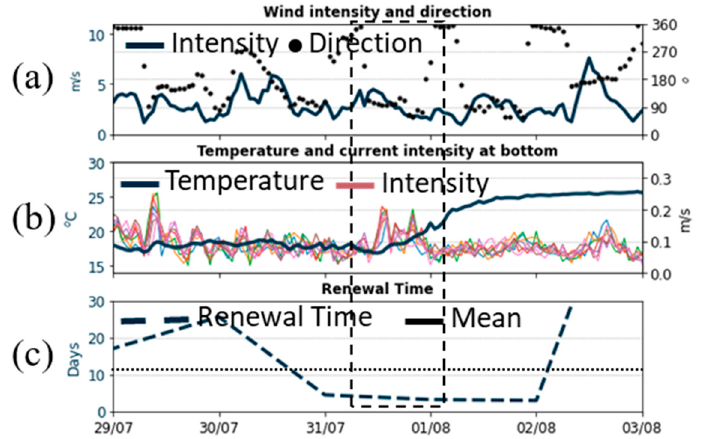
Figure 10. Detailed evolution of the third episode of abrupt temperature increases in Tarragona harbour. Line ( a ) wind intensity (solid line) and wind direction (black dots). Line ( b ) temperature (thick line) and current speed near the seabed (the thin coloured lines represent the intensity in the deeper layers). Line ( c ) turnover times (the black line is the average turnover time of the harbour). The dashed black squares correspond to the day of downwelling.